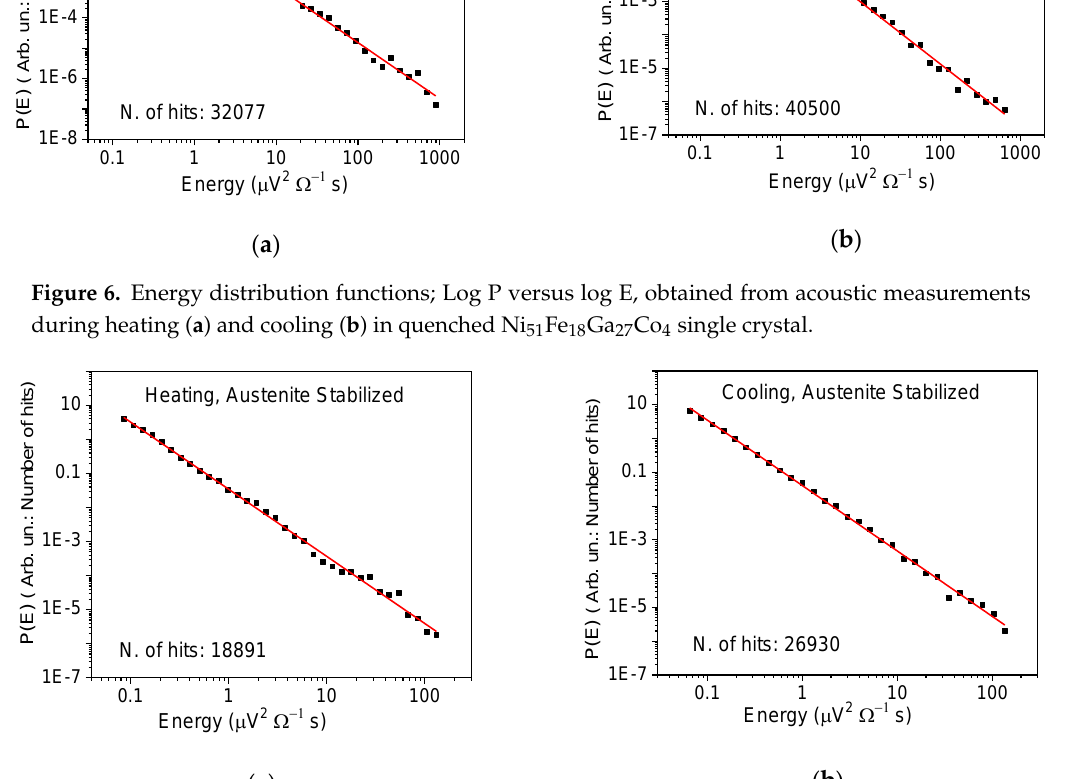
∑ 𝐸 𝑖𝑖 ⁄ and N is 𝑁